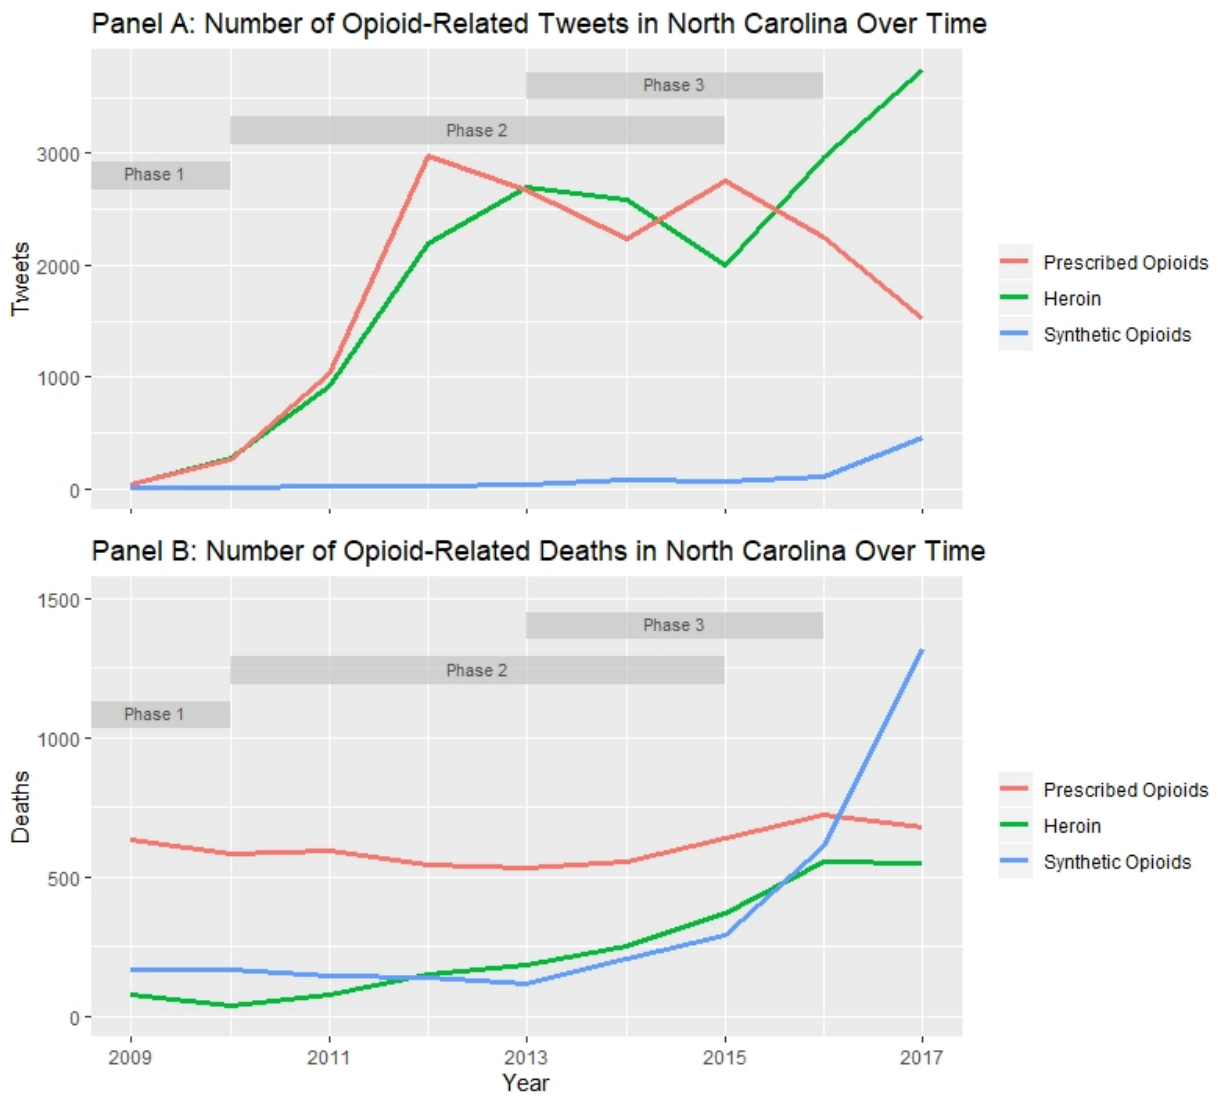
Figure 1. Pattern of opioid-related deaths and tweets in North Carolina over